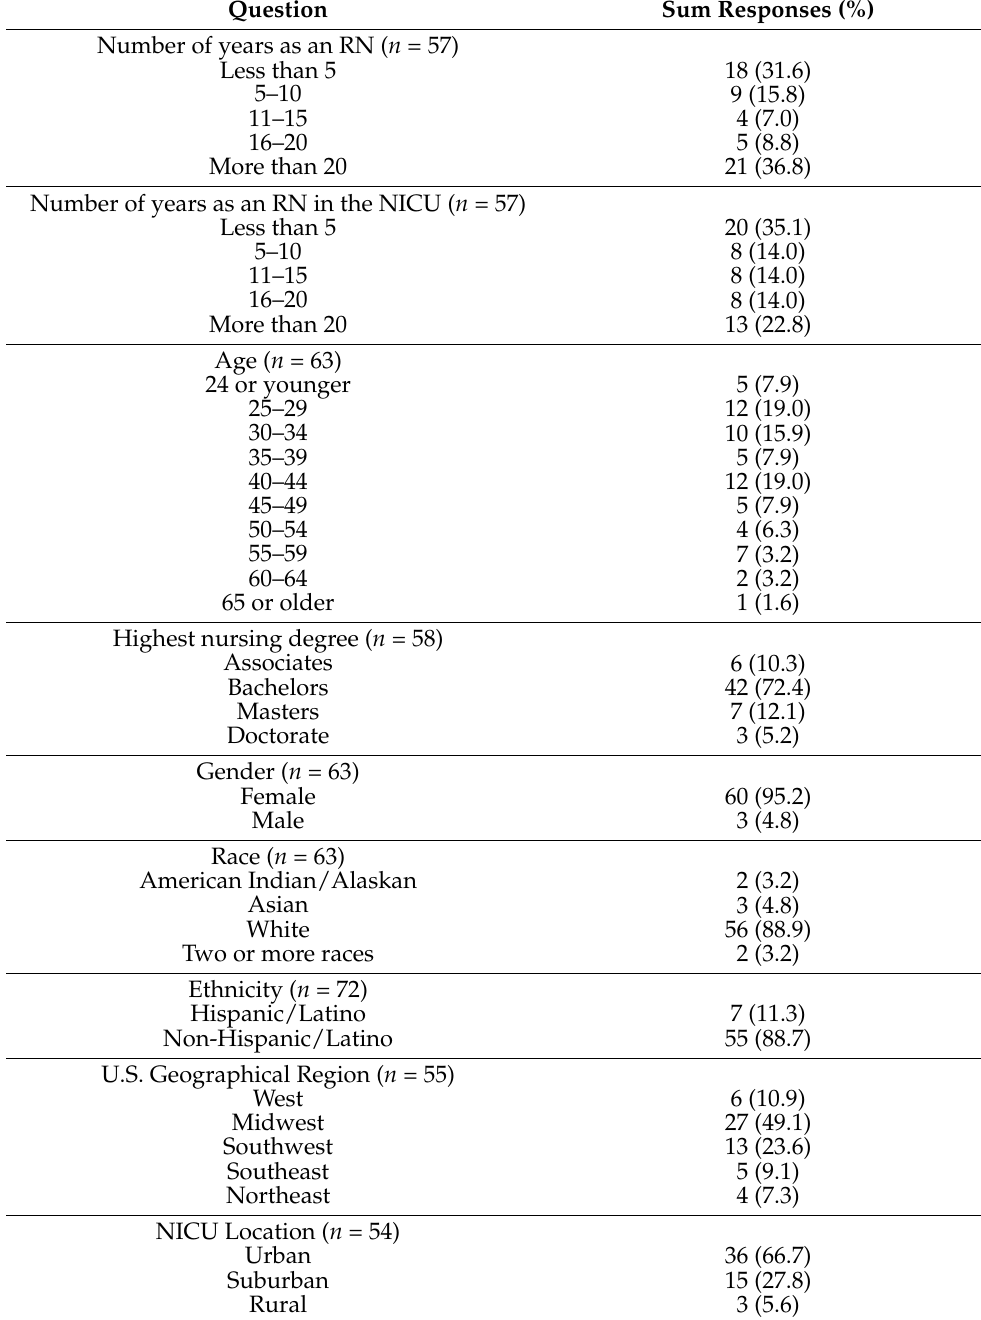
Table 1. Description of respondent